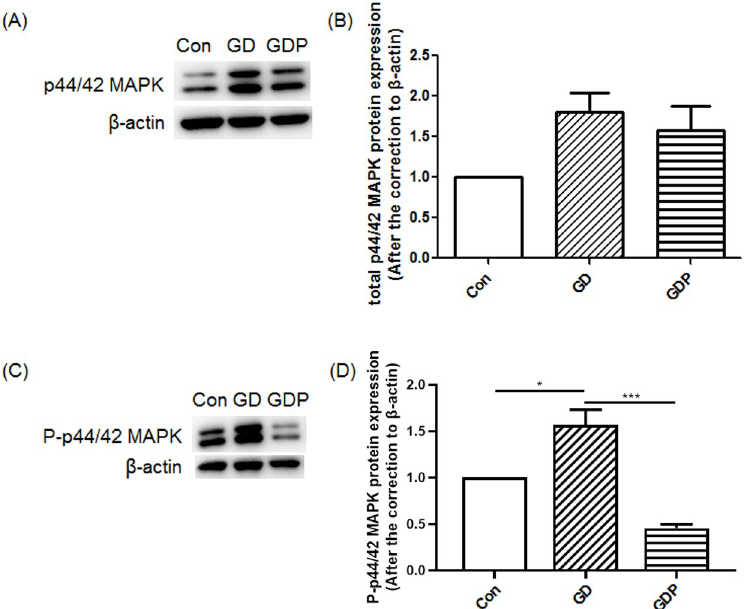
Fig 2. Mitogen-activated protein kinase (MAPK) and phosphor-p44/42 MAPK (P-MAPK) protein expression in GCs. GCs were incubated in the absence (Con) or presence of Dex for 48 h (GD) or Dex for 48 h with PD98059 added 4 h before the end of the incubation (GDP). Relative density ratios were calculated by setting the control group value as one. Data are expressed as the mean + SEM. All data presented are representative of at least three separate experiments. � p < 0.05, ��� p <